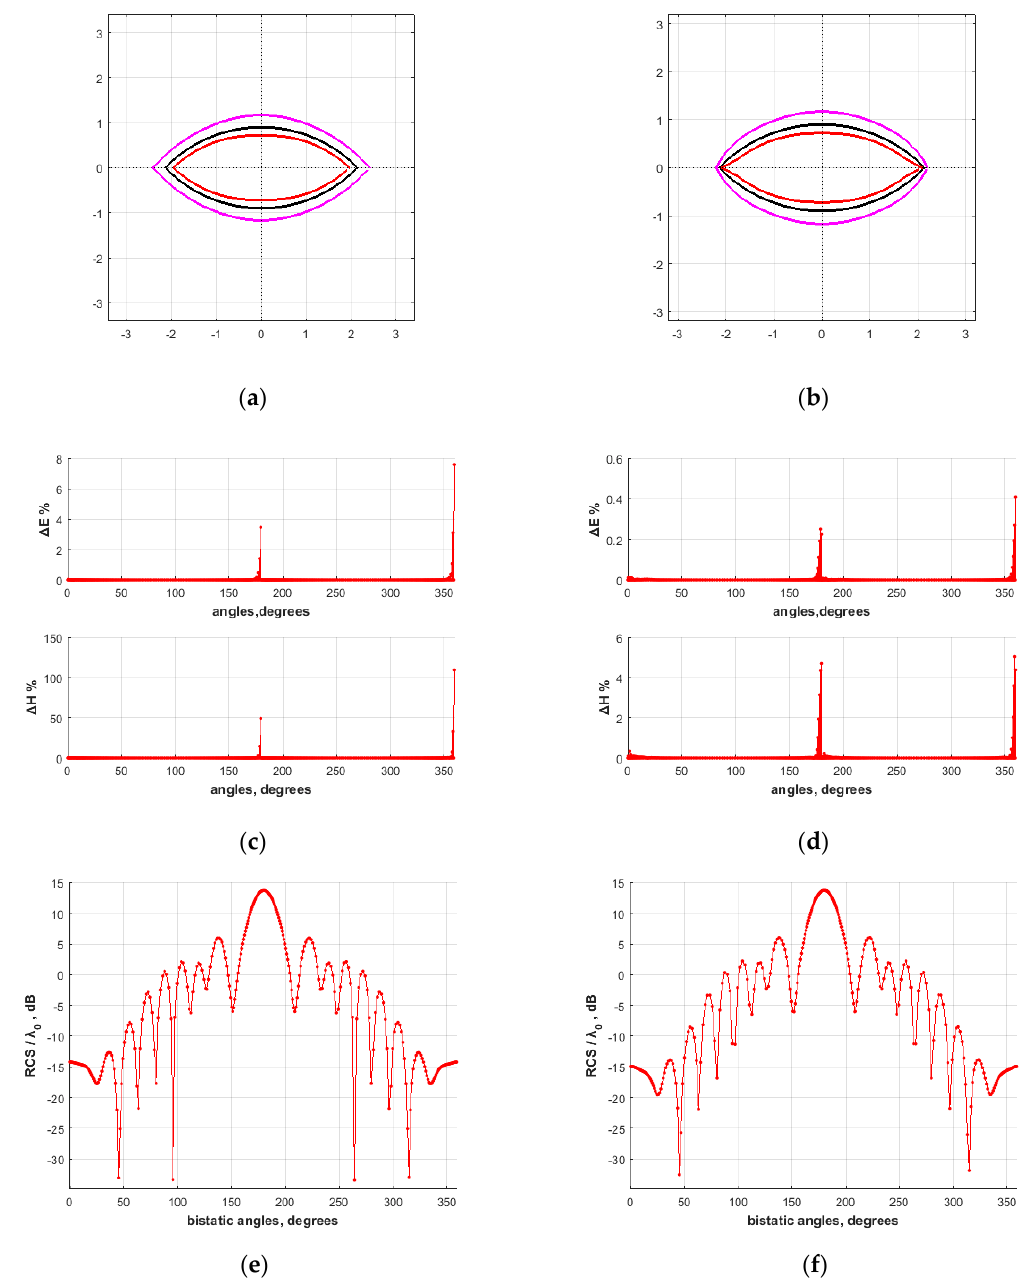
Figure 12. Large arc displacement d = 0.7 ρ = 2.1 λ : ( a ) geometry and conformal auxiliary surfaces; ( b ) geometry and improved auxiliary surfaces; ( c ) conformal ∆ E and ∆ H error; ( d ) improved ∆ E and ∆ H error; ( e ) conformal RCS; and ( f ) improved RCS.